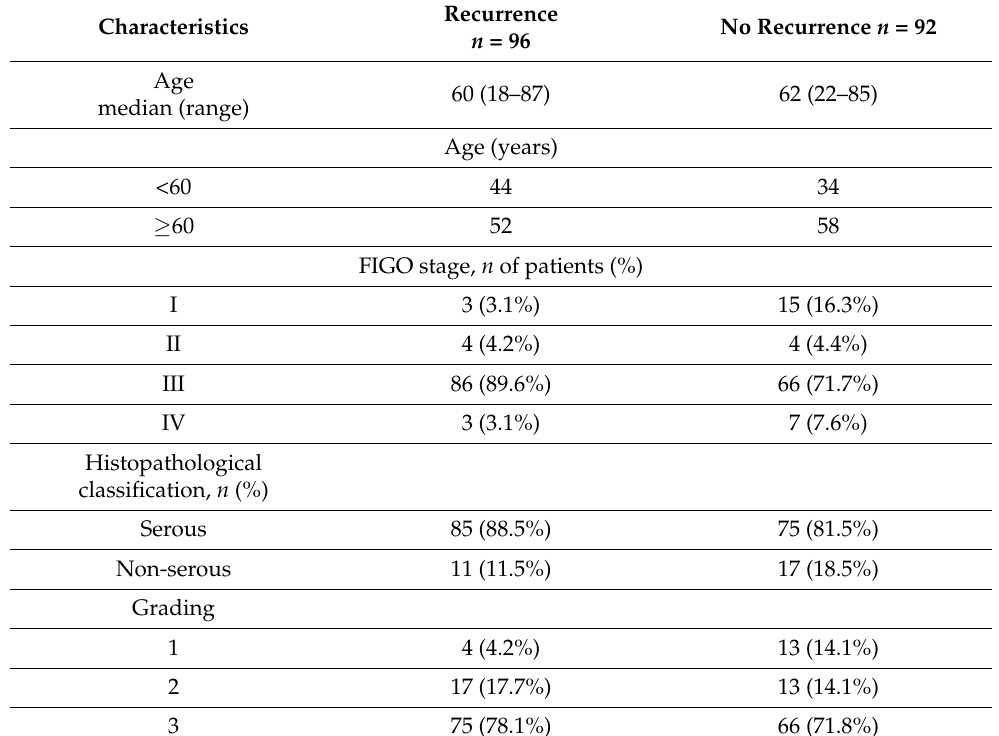
Table 1. Patient